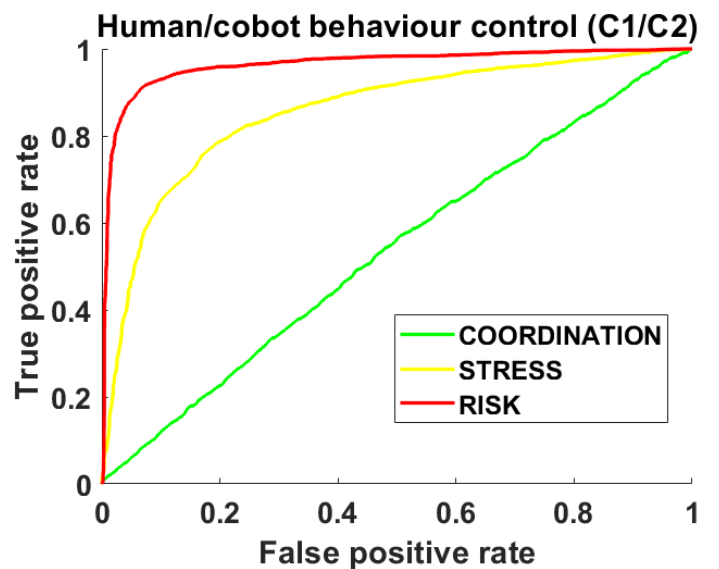
Figure 10. ROC analysis of the models of the centroids (C1, C2 by SVM) for the real and simulated use cases: (a) UC1: coordinated Cobot learning task in green. (b) UC2: Simulated stressed worker in yellow. (c) UC3: Risky behaviour of Cobots in red.